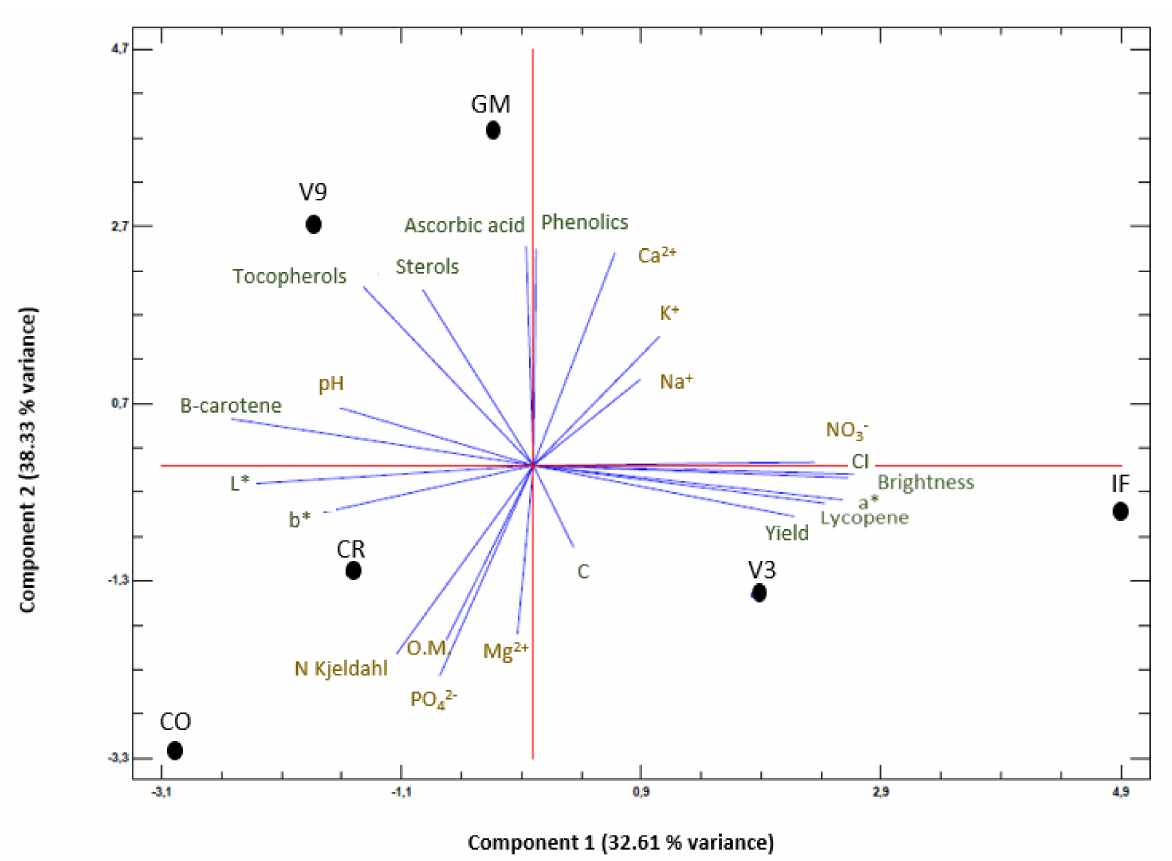
Figure 3. PCA-relationships between tomato yield, tomato quality and chemical proprieties of the